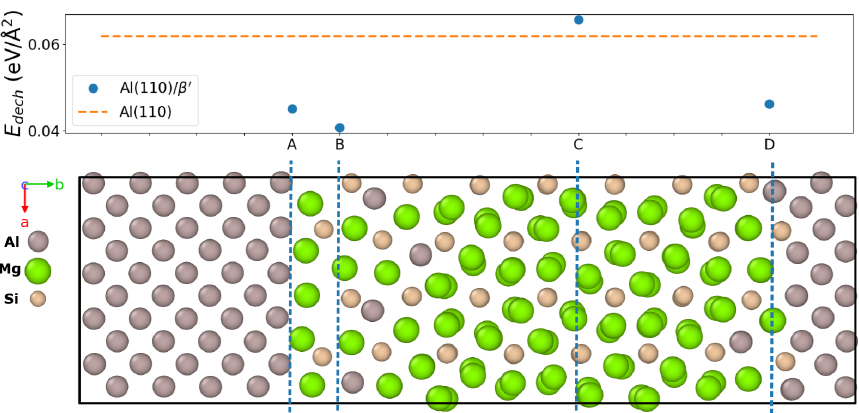
Figure 5. (Color online). Relaxed DFT model of the Al(110) interface constructed based on the TEM images, with possible decohesion interfaces and corresponding decohesion energies.